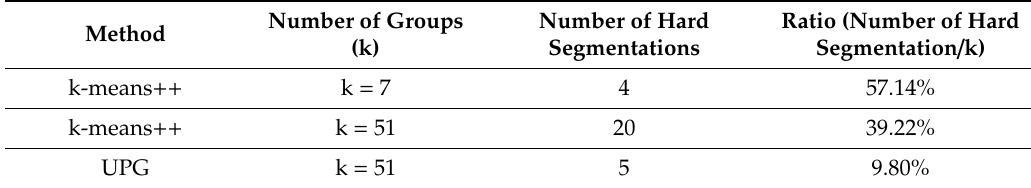
Figure 21. Illustration of contrast experiment results: ( a ) k-means++ result (k = 7), the left parts of the figures illustrate the process of choosing the optimal cluster number; ( b ) k-means++ result (k = 51).